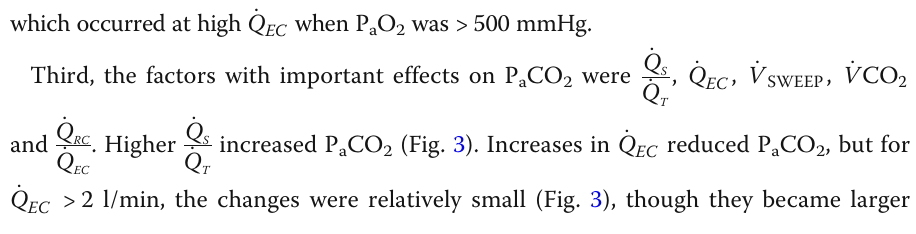
_ Q S _ , the higher the _ Q EC required to achieve Q T